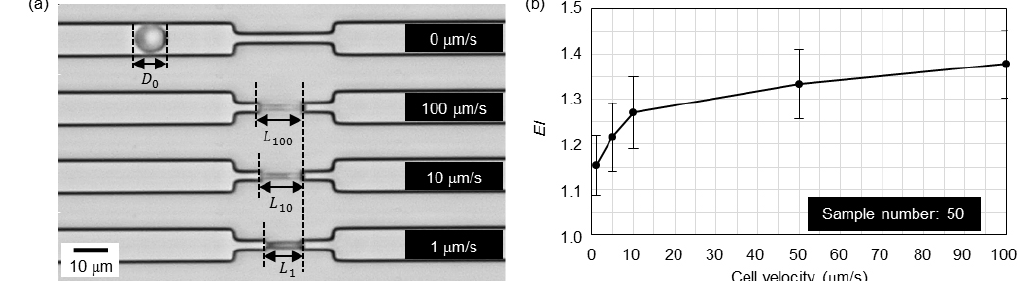
Figure 6. Extensibility evaluation. ( a ) An example of the measurement of cell length and ( b ) EI with respect to the cell